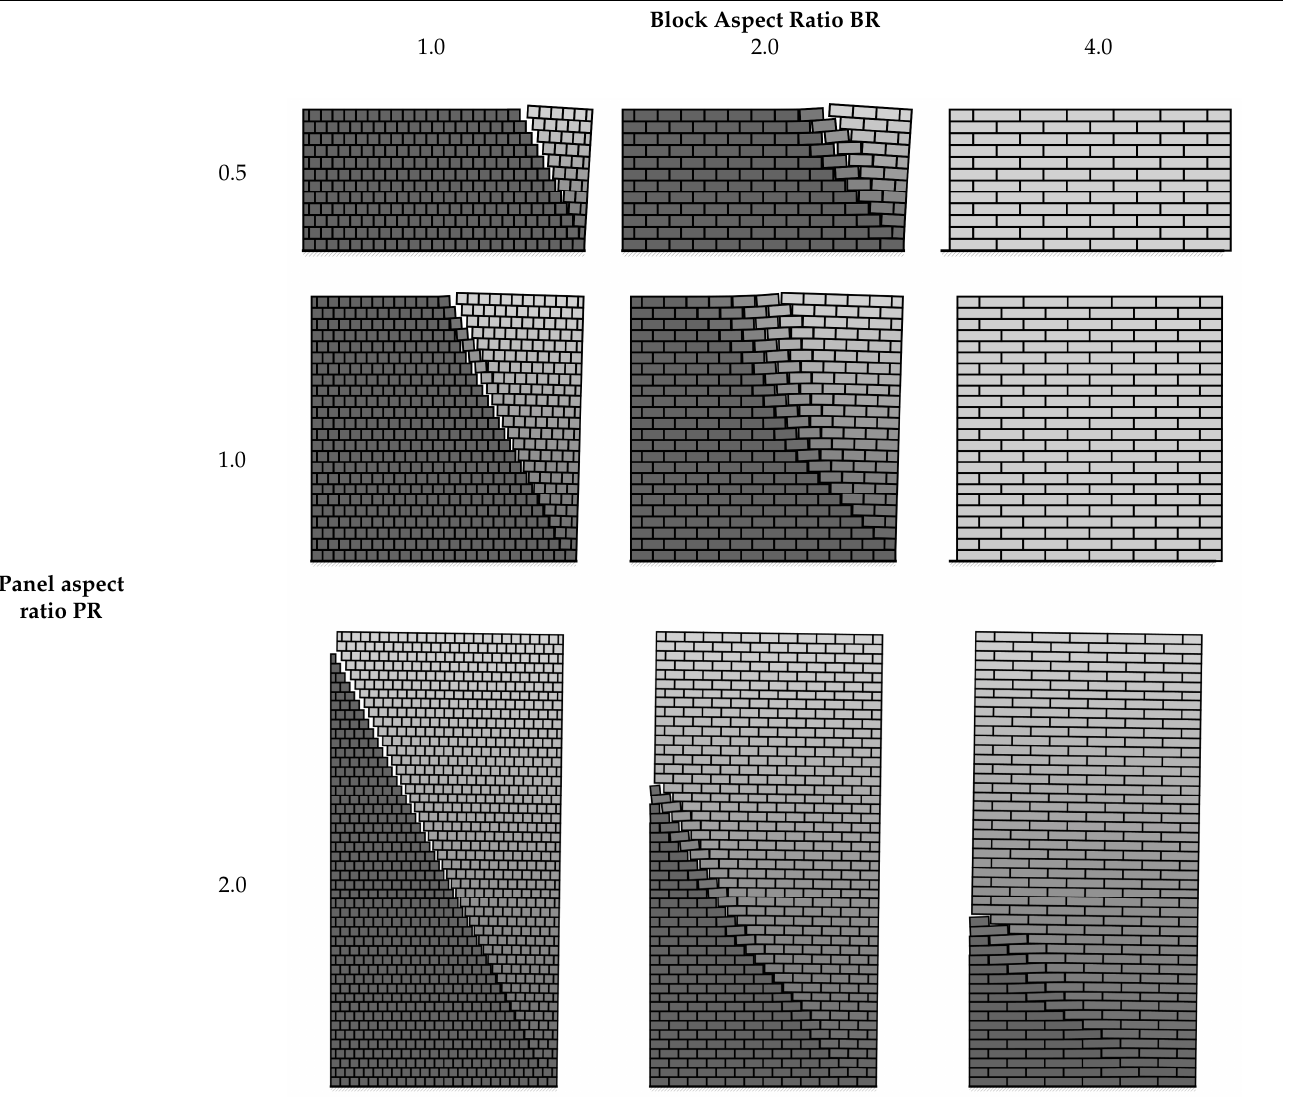
Table A2. Failure Mechanisms for Running bond with µ = 0.65.